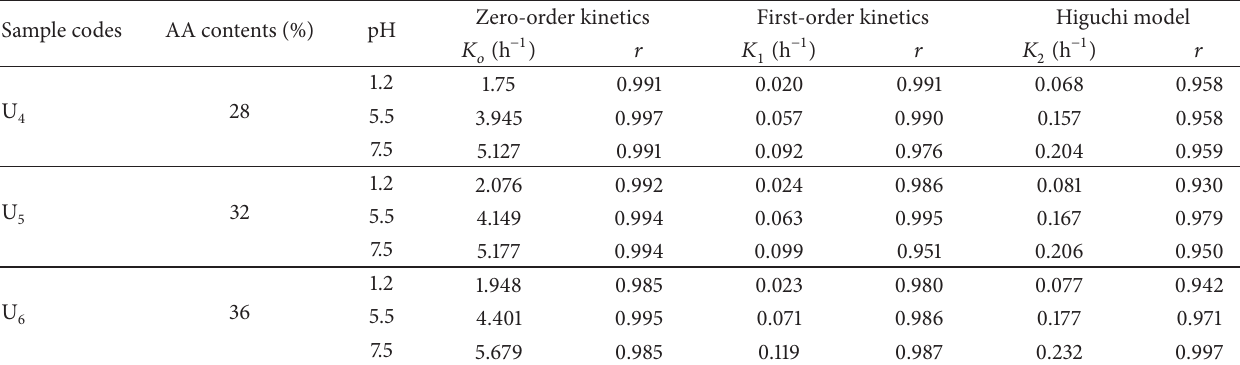
Table 6: Effect of different concentrations of acrylic acid on drug release kinetics of AA/Gelatin hydrogels in solutions of different pH values using EGDMA as cross-linking agent (0.70% w/w).